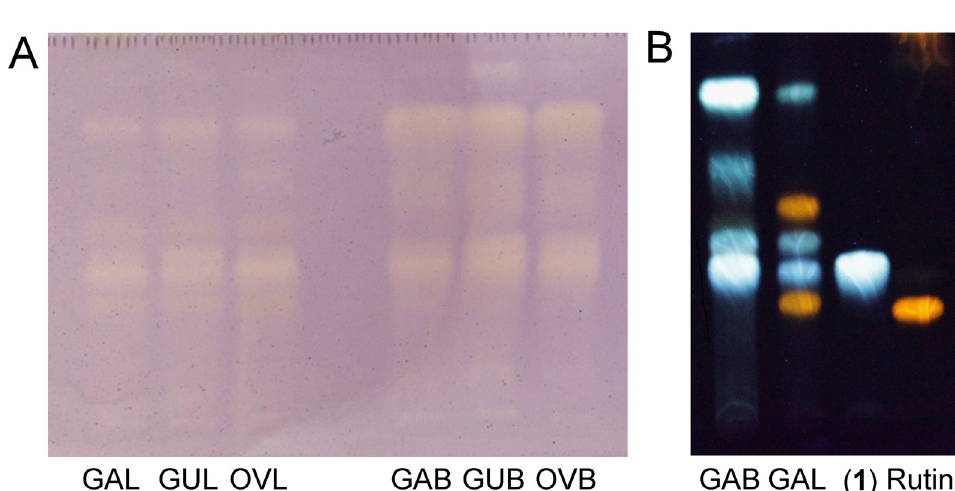
FIGURE 2 - A) DPPH-TLC autographic assay of leaf extracts from Gauchito (GAL), Guri (GUL) and Oro Verde (OVL) (left), and bract extracts from Gauchito (GAB), Guri (GUB) and Oro Verde (OVB) (right). B) TLC chromatogram of GAB and GAL extracts versus chlorogenic acid (1) and Rutin, revealed with Natural Product-PEG reagents. System solvent: ethyl acetate: formic acid: acetic acid: water